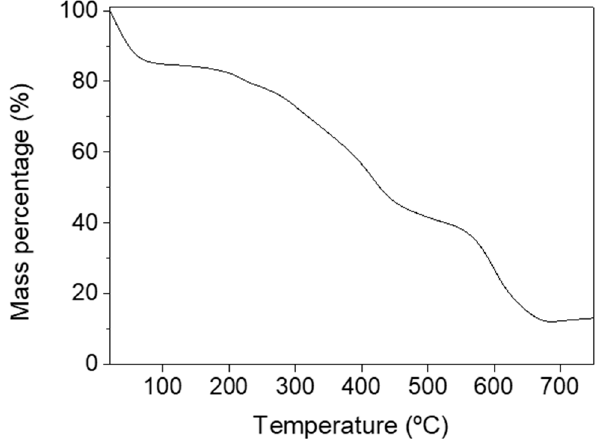
Figure 1. TGA curve of PVP/metal nitrate composite nanofibers.